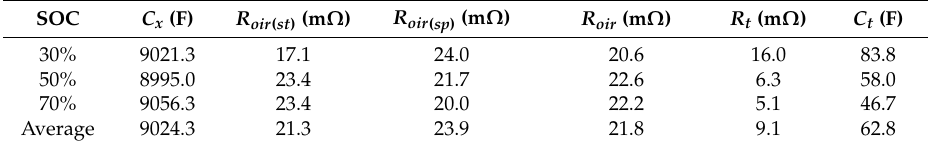
Table 5. Parameter value of PNGV battery model.